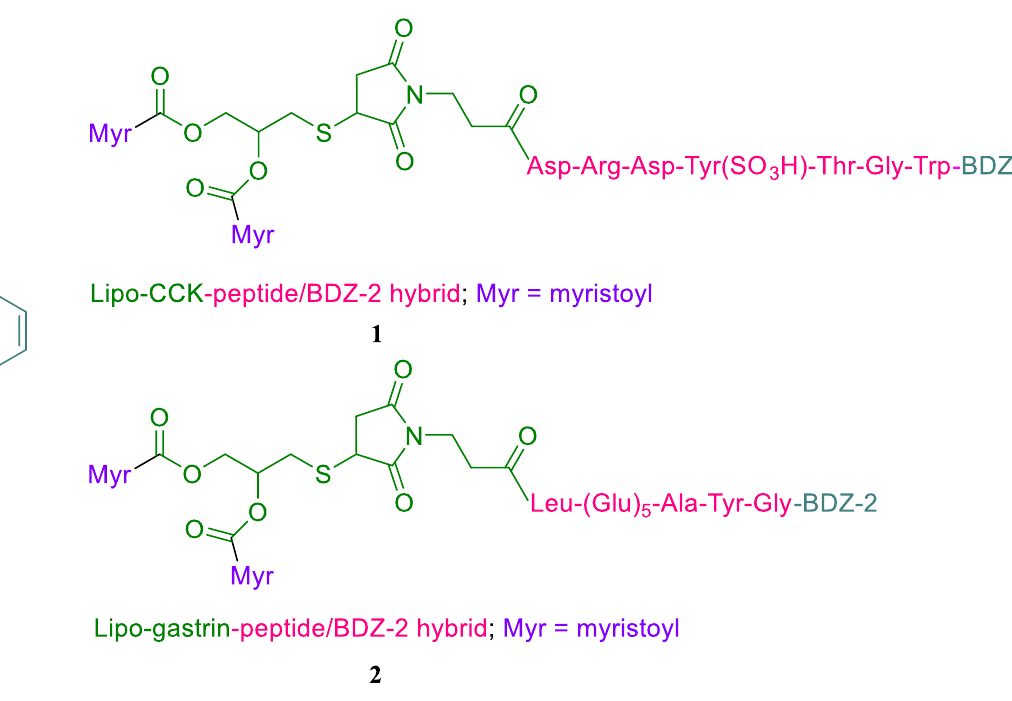
Figure 12. Peptides-benzodiazepine (BDZ-2) hybrid molecules.